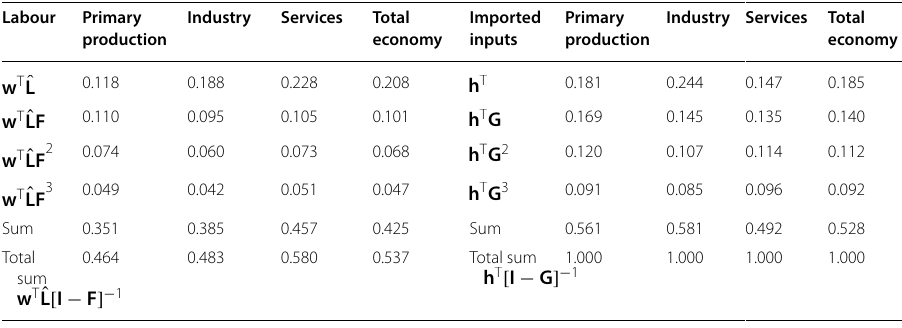
Table 1 Sectoral dated quantities of direct labour and imported inputs; Greece Labour Primary Industry production